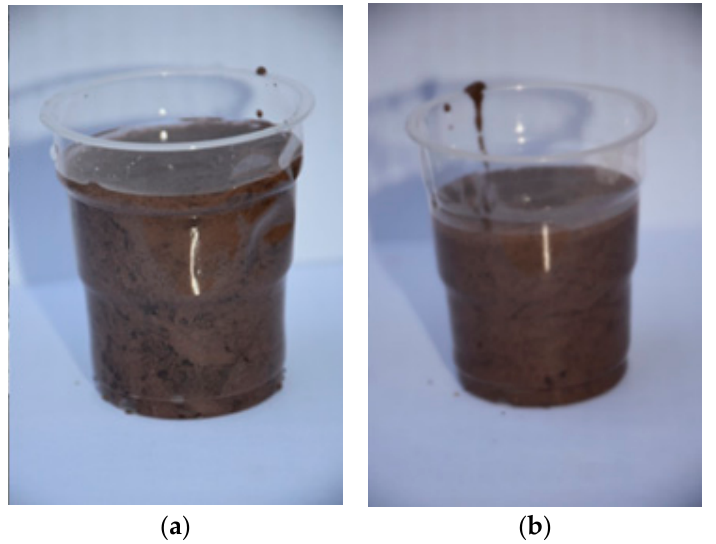
Figure 4. Bottom floc sampling. ( a ) Sampling without shear conditions; ( b ) Sampling under shear conditions.